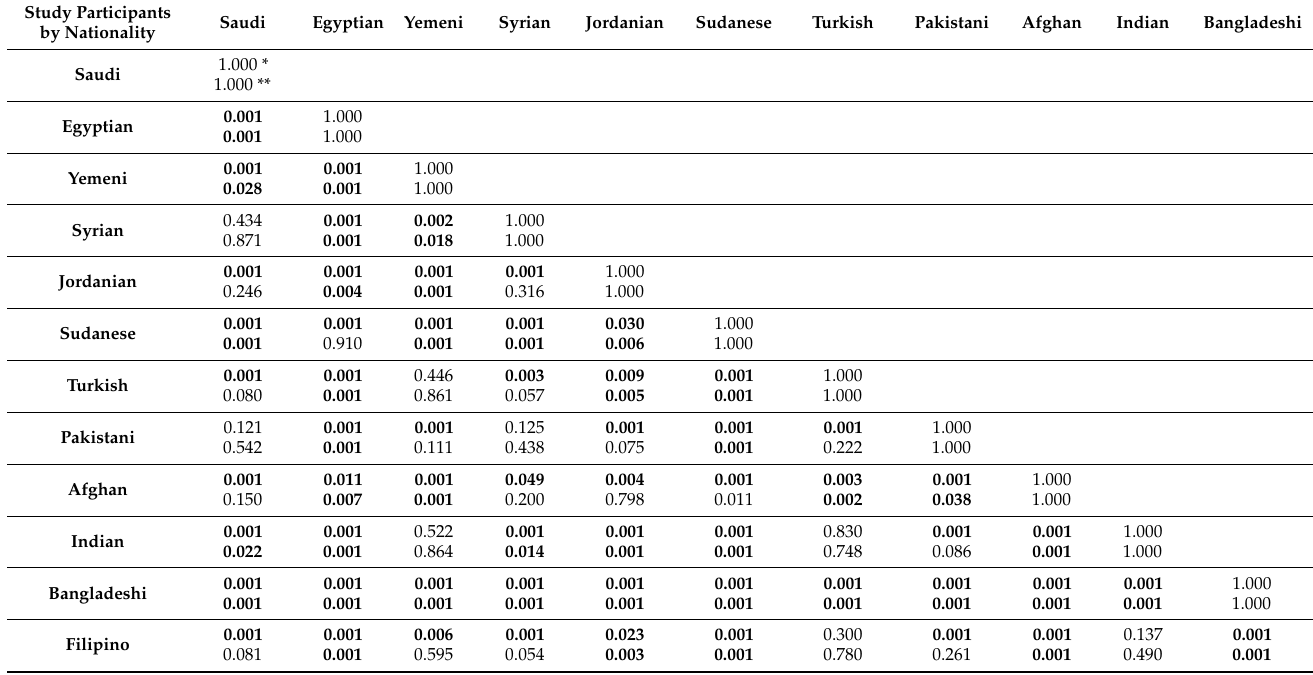
Table 3. Matrix of post hoc association coefficients for different pairs of participant subgroups based on their nationality.